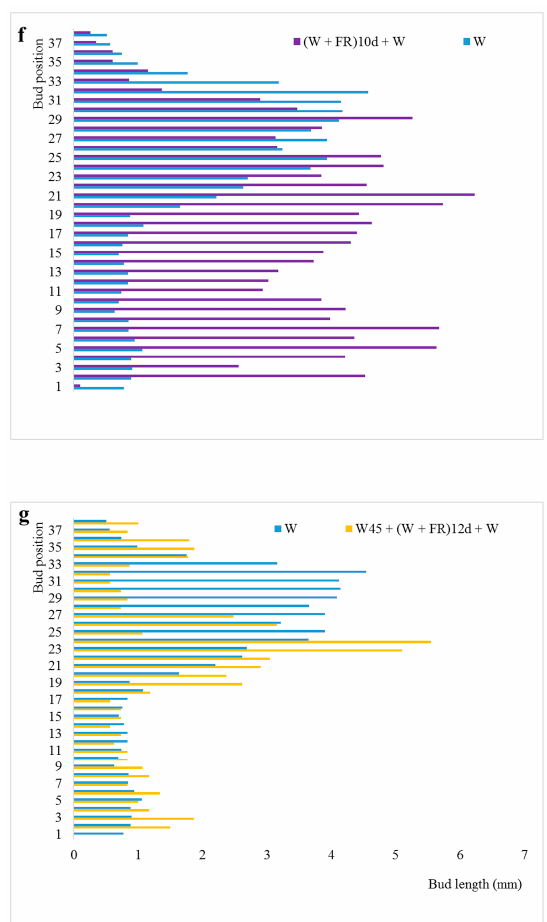
Figure 1. Axillary bud length under different ratio of red to far-red light (R:FR) treatments. ( a – e ) Bud length was measured 145 days after planting. ( f – g ) Bud length was measured 64 days after planting.